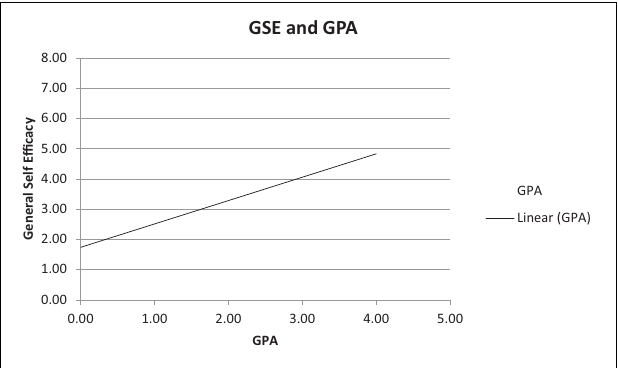
FIGURE 1 | Linear relationship between GPA and general self-efficacy.